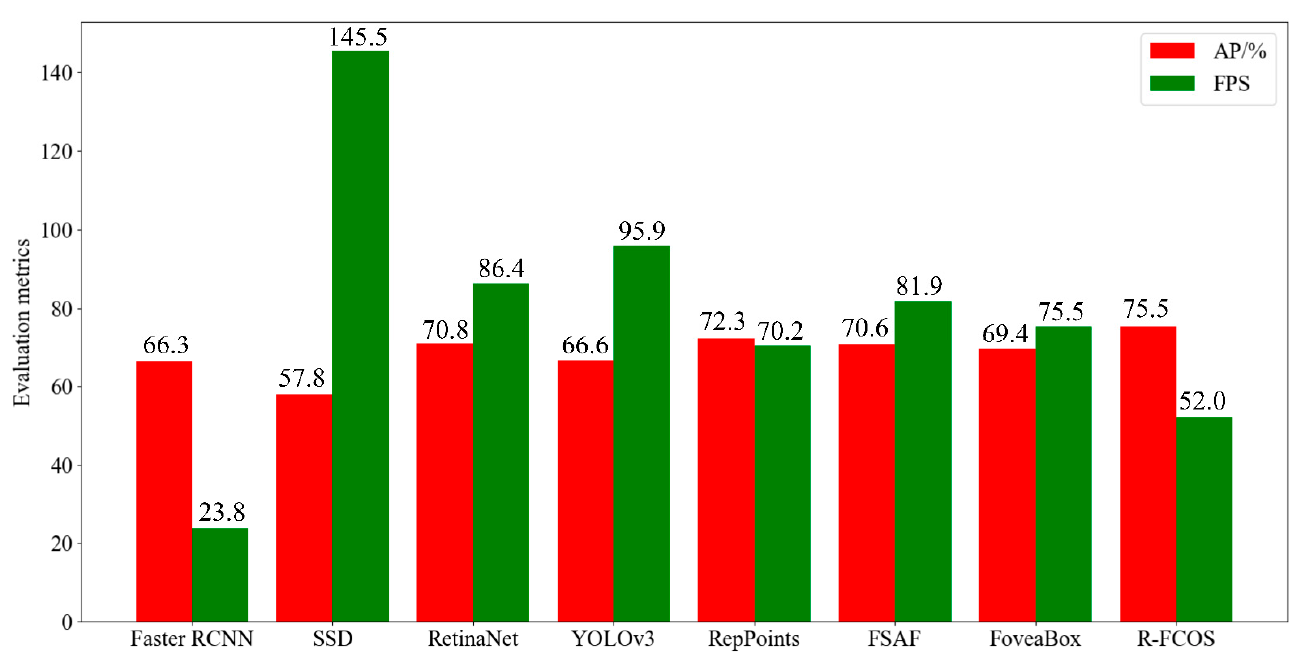
Figure 11. The bar graph of different methods on LS-SSDD-v1.0.